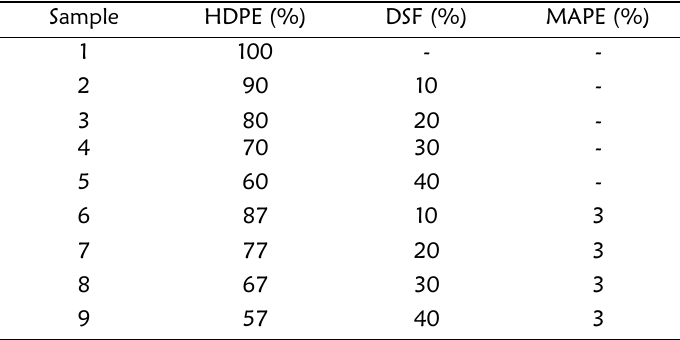
Table 1: Composition of the composite